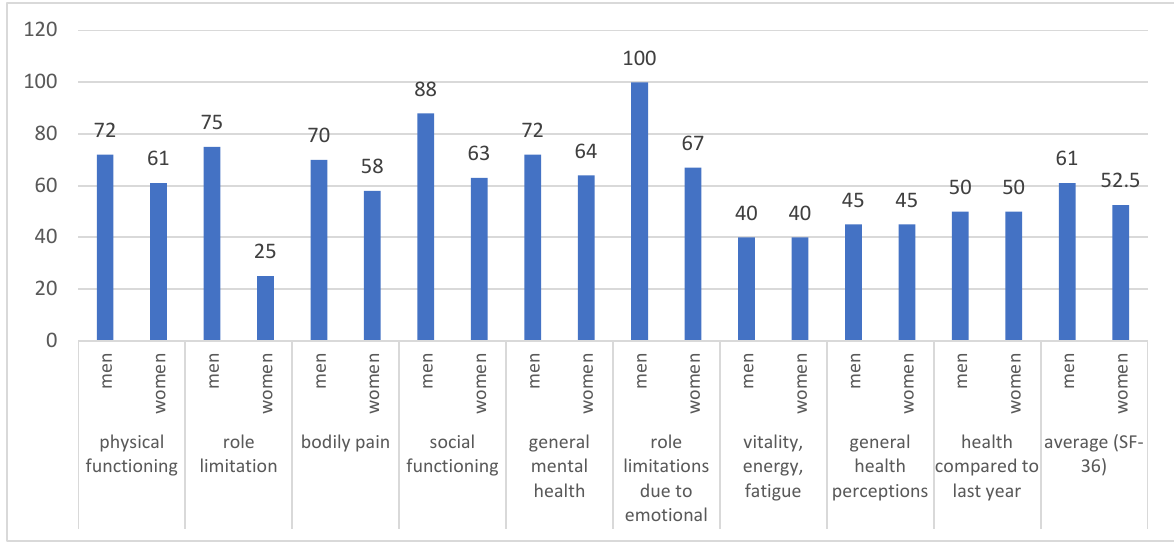
Figure 4. SF-36 scales for both genders .